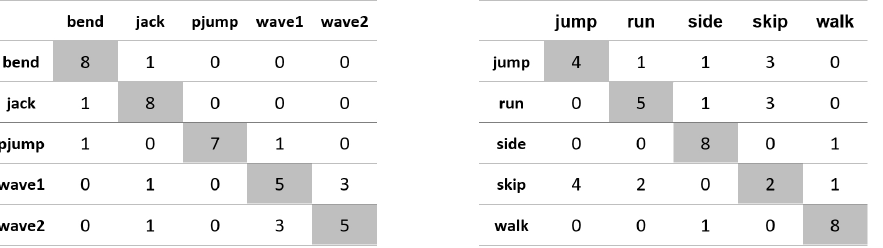
Figure A22. Confusion matrices for the experiment using the ‘upper-occlusion’ database, MBR width and Euclidean distance.